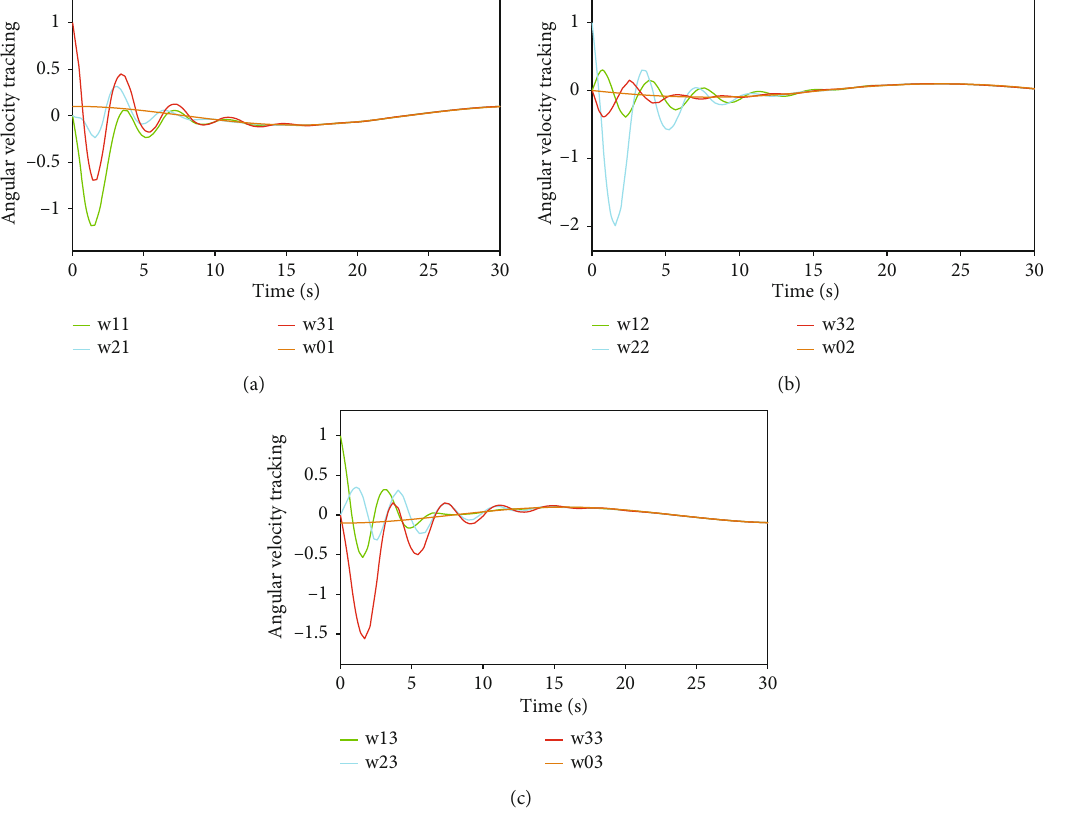
Figure 5: Angular velocity